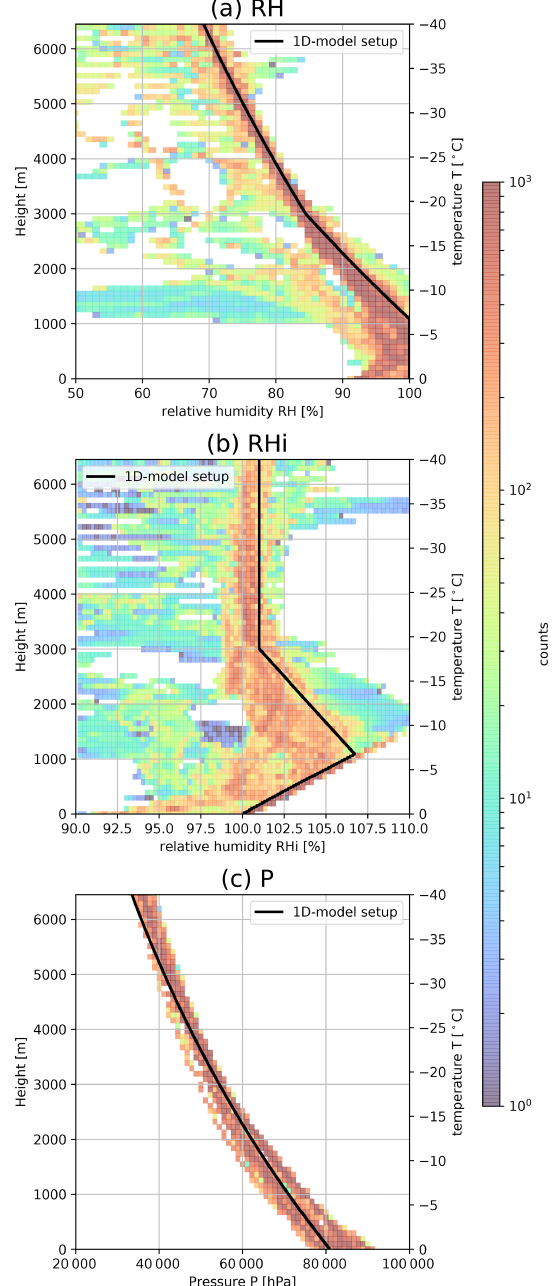
Figure B5. Setup of atmospheric variables in the 1D simulations (Sect. 3.2) (black line), which was chosen based on the histograms from the ICON-LEM simulation (the histogram is shown in the background, O20). The histogram is filtered to include only profiles for which the rain rate exceeds 1mmh − 1 . (a) Temperature, (b) rel- ative humidity with respect to water, and (c) relative humidity with respect to ice. The height of the melting temperature 0 ◦ C is set to 0m, and other heights are calculated assuming a temperature gra- dient of 0.0062Km − 1 . Counts in the ICON-LEM simulations from O20 are